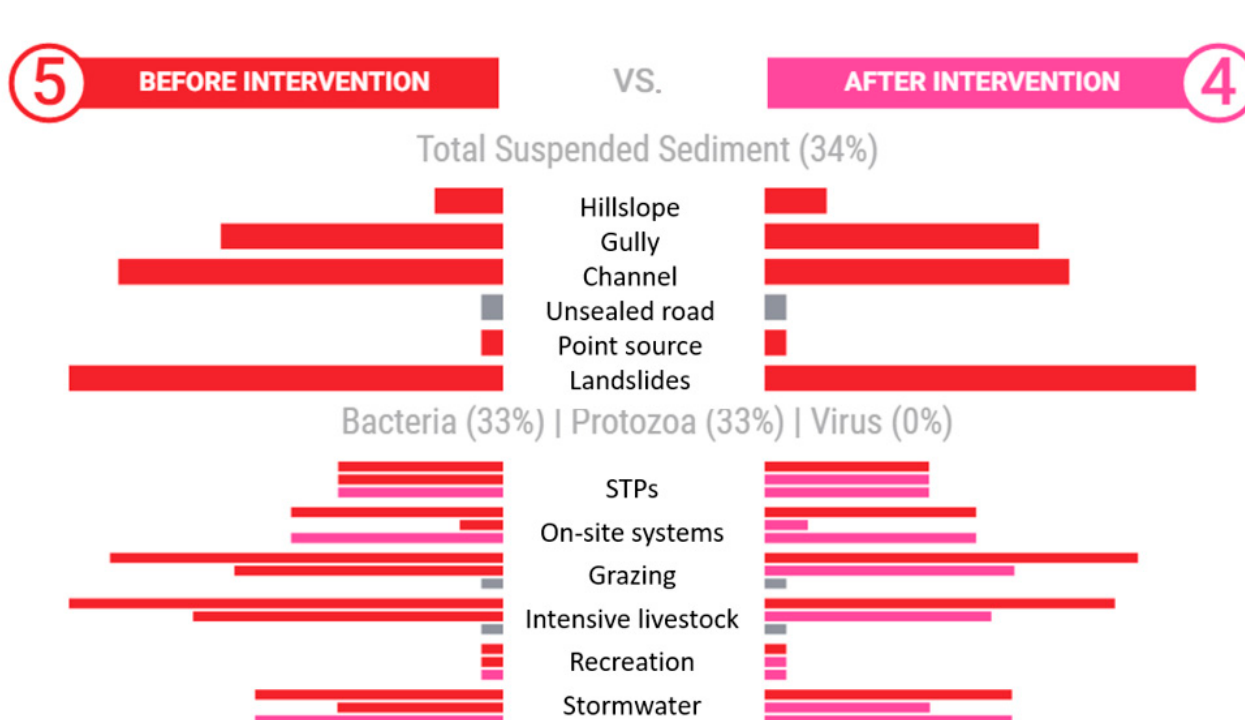
Figure 3. CIDSS graphical output for risk and hazardous process load for the current state (before intervention) and after intervention based on scenario’s portfolio of interventions for reducing drinking water quality risk to CGW. Red bars represent very-high risk (5) and magenta bars represent high risk (4). Grey bars represent zero load. Here, grazing and intensive livestock are not a source of viral load. There are no data presented for Unsealed roads in this case study. Bar length is indicative of the size of load from the hazardous processes. For example, Landslides are the largest source of TSS. Intensive livestock is the largest source of bacteria and protozoa. The triplet bars for pathogens represent each hazard—bacteria (top), protozoa (middle) and virus (lower). The values in parentheses represent the weightings applied to each hazard in the optimization.